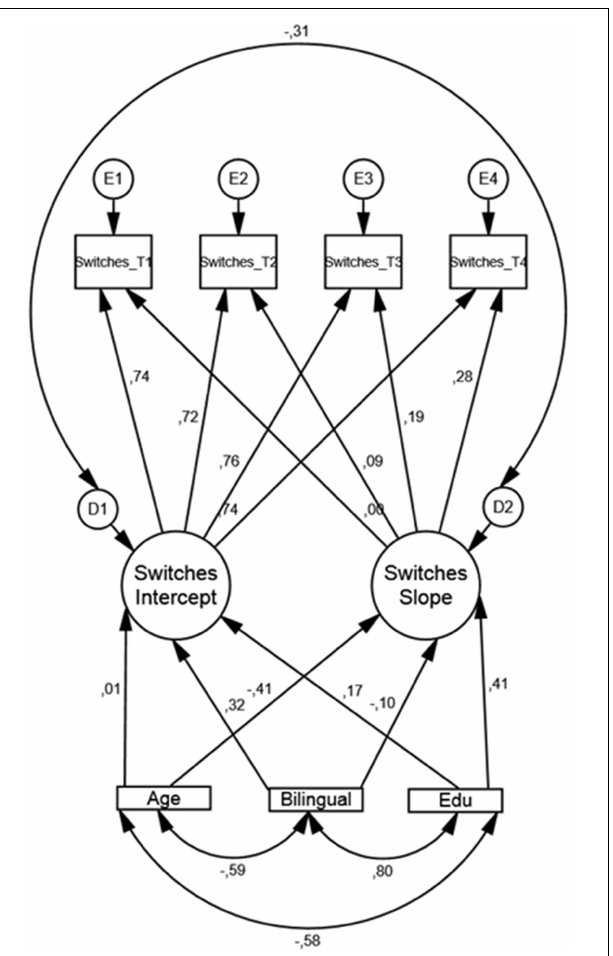
FIGURE 2 | Conditional LGM for switching performance with bilingualism, age, and education as covariates along with standardized regression weights. Edu = years of formal schooling, Bilingual = (coded as 1 = yes and 0 = no).